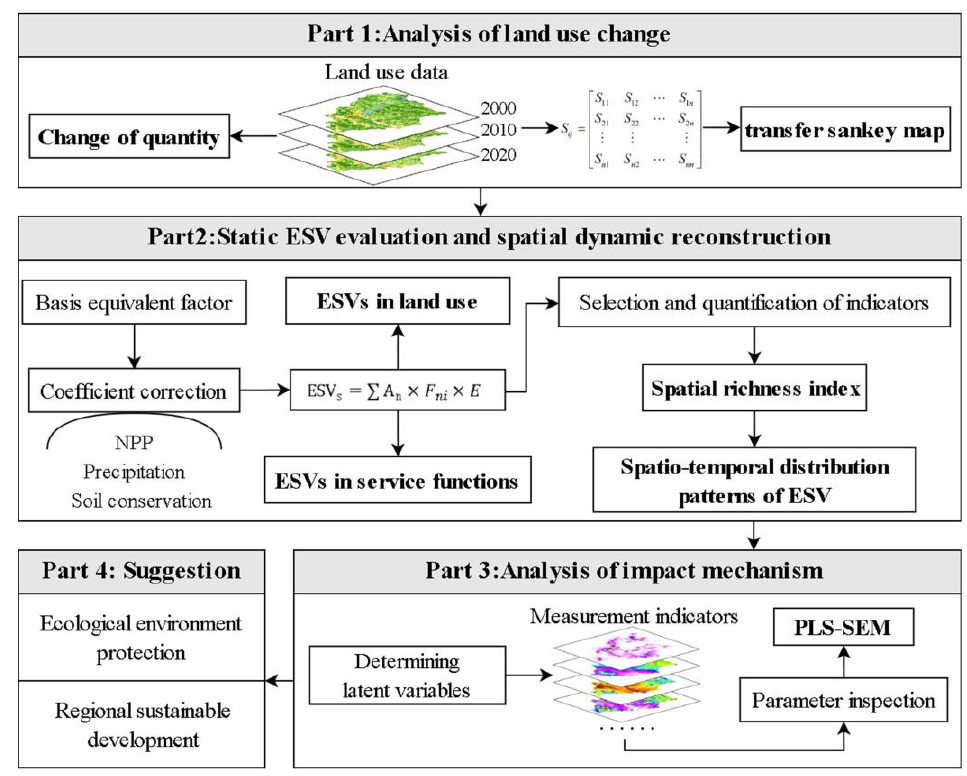
Figure 1. Research framework.